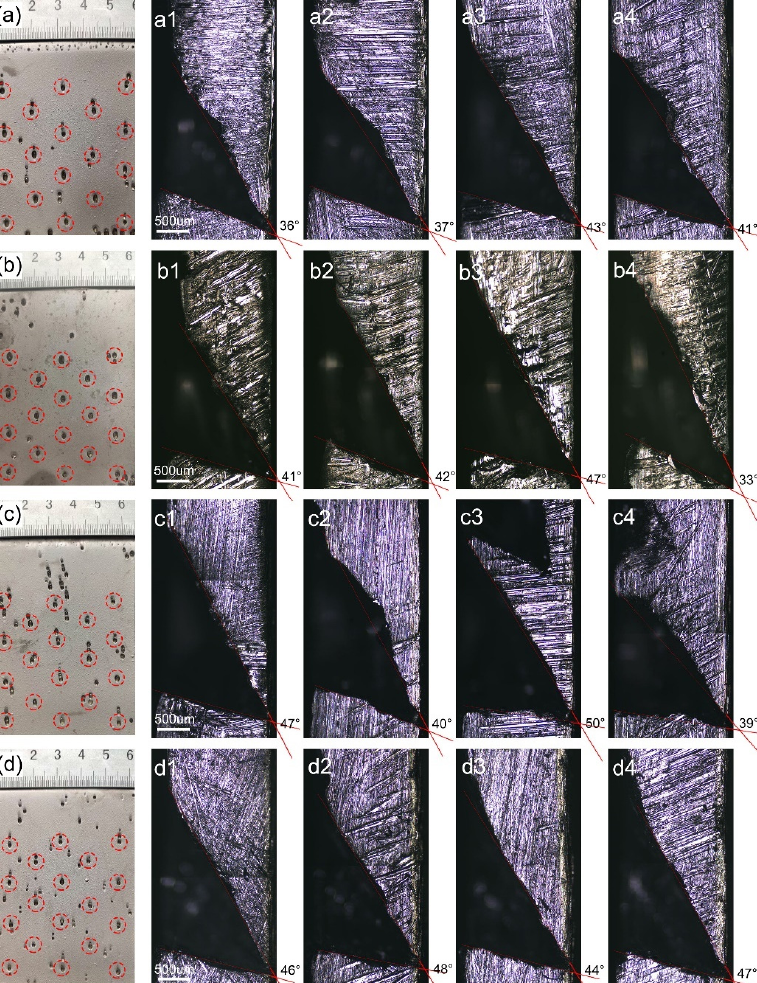
Figure 6. The morphology of bell-mouthed macropores in a deposition under different current den- sities: ( a ) 1 A/dm 2 , 180 h; ( b ) 1.5 A/dm 2 , 120 h; ( c ) 2 A/dm 2 , 90 h; ( d ), 2.5 A/dm 2 , 72 h. a – d and a1–d4 are the front and cross-sectional morphology of the macropore, respectively. Table 3. Cross-section angles of bell-mouthed macropores in a deposition at different current den- sities.